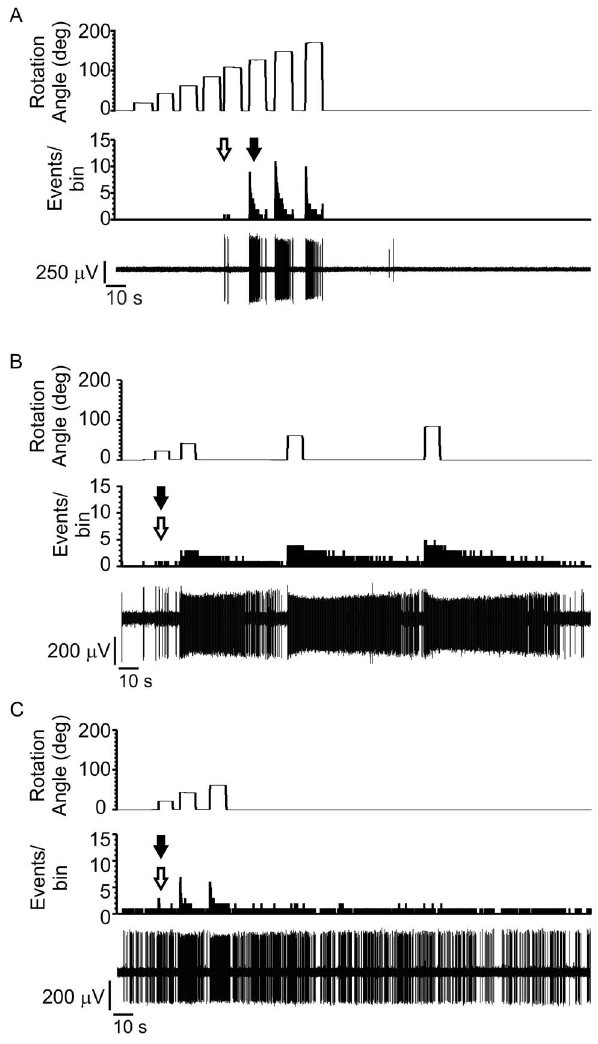
Figure 2. Spinal cord neuron responses to knee joint rotation. For each of (A), (B) and (C) the top trace shows the rotation stimulus set with rotation angle increasing in 20 degree steps and extending at least 40 degrees above the tonic firing threshold. The middle trace shows the PSTH of the response to the rotation set. White arrow denotes phasic threshold, black arrow denotes tonic threshold and bin width=0.05 ms. The bottom trace shows the neural waveform during the joint rotation stimulus set. (A) Response from a cell showing no ongoing spike activity and high response threshold (B) A cell showing little ongoing spike activity, low threshold and extended firing after stimulus offset (C) A cell showing high ongoing spike activity with a low response threshold.